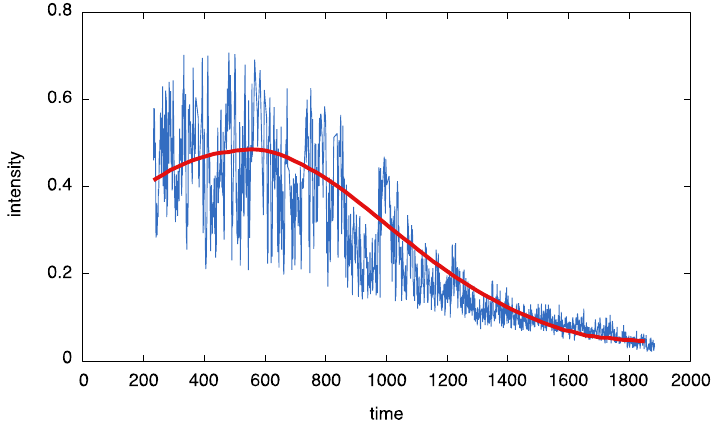
Figure 21. Light-curve of the Tiangong-1 passing over Rome on the 15/02/2018 sampling at 24 fps in blue; in red, the synthetic light-curve found by the proposed